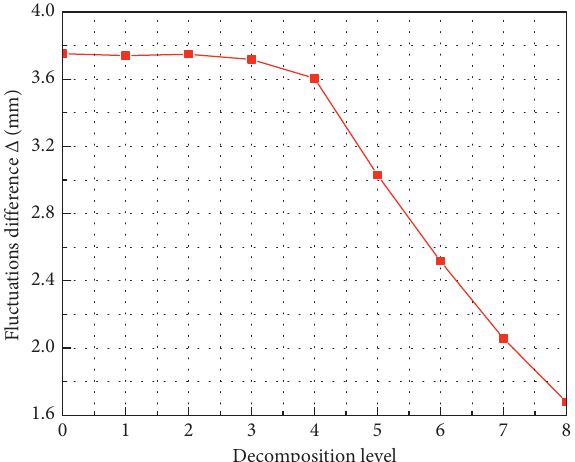
Figure 3: The variation of fluctuations difference Δ with de- composition